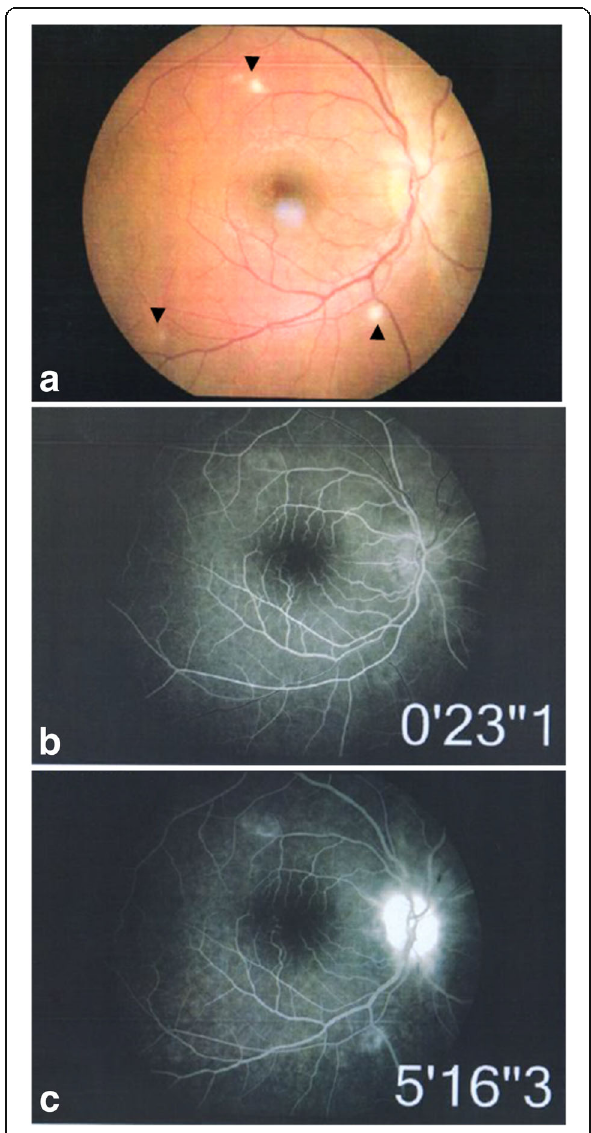
Fig. 3 A 32-year-old female patient presented with vision blurring in the right eye. The patient reported having been recently scratched by a kitten. There was a right relative afferent pupillary defect. Color fundus photograph shows retinal infiltrates (arrowheads) ( a ). Fluorescein angiography shows mild peripheral staining of retinal lesions ( b , c ) and late optic disc hyperfluorescence ( c ). Serology confirmed a diagnosis of cat-scratch